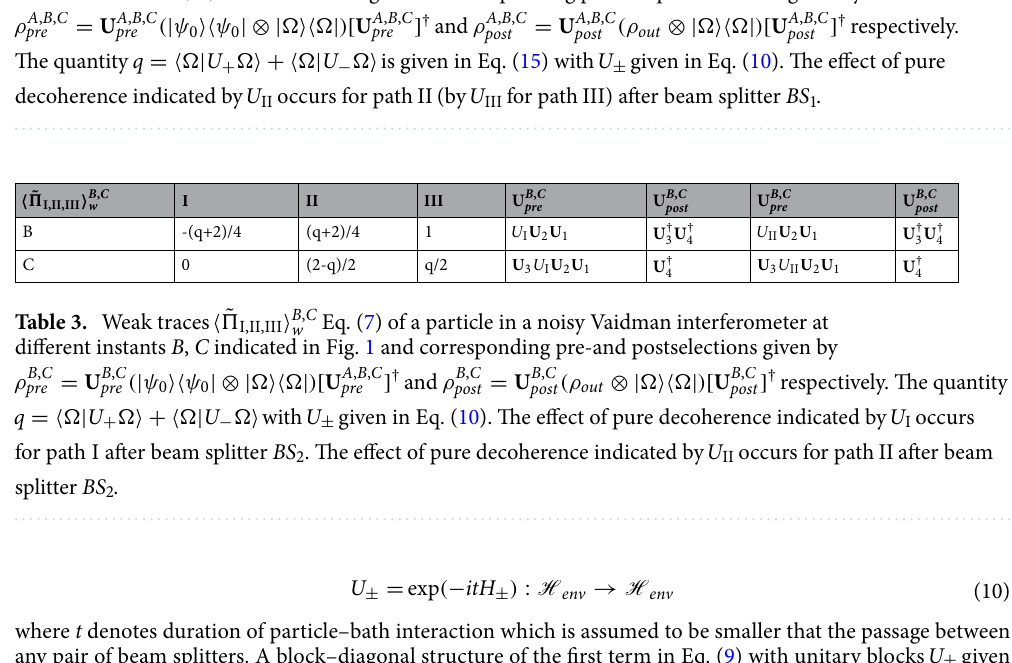
where t denotes duration of particle–bath interaction which is assumed to be smaller that the passage between any pair of beam splitters. A block–diagonal structure of the first term in Eq. (9) with unitary blocks U